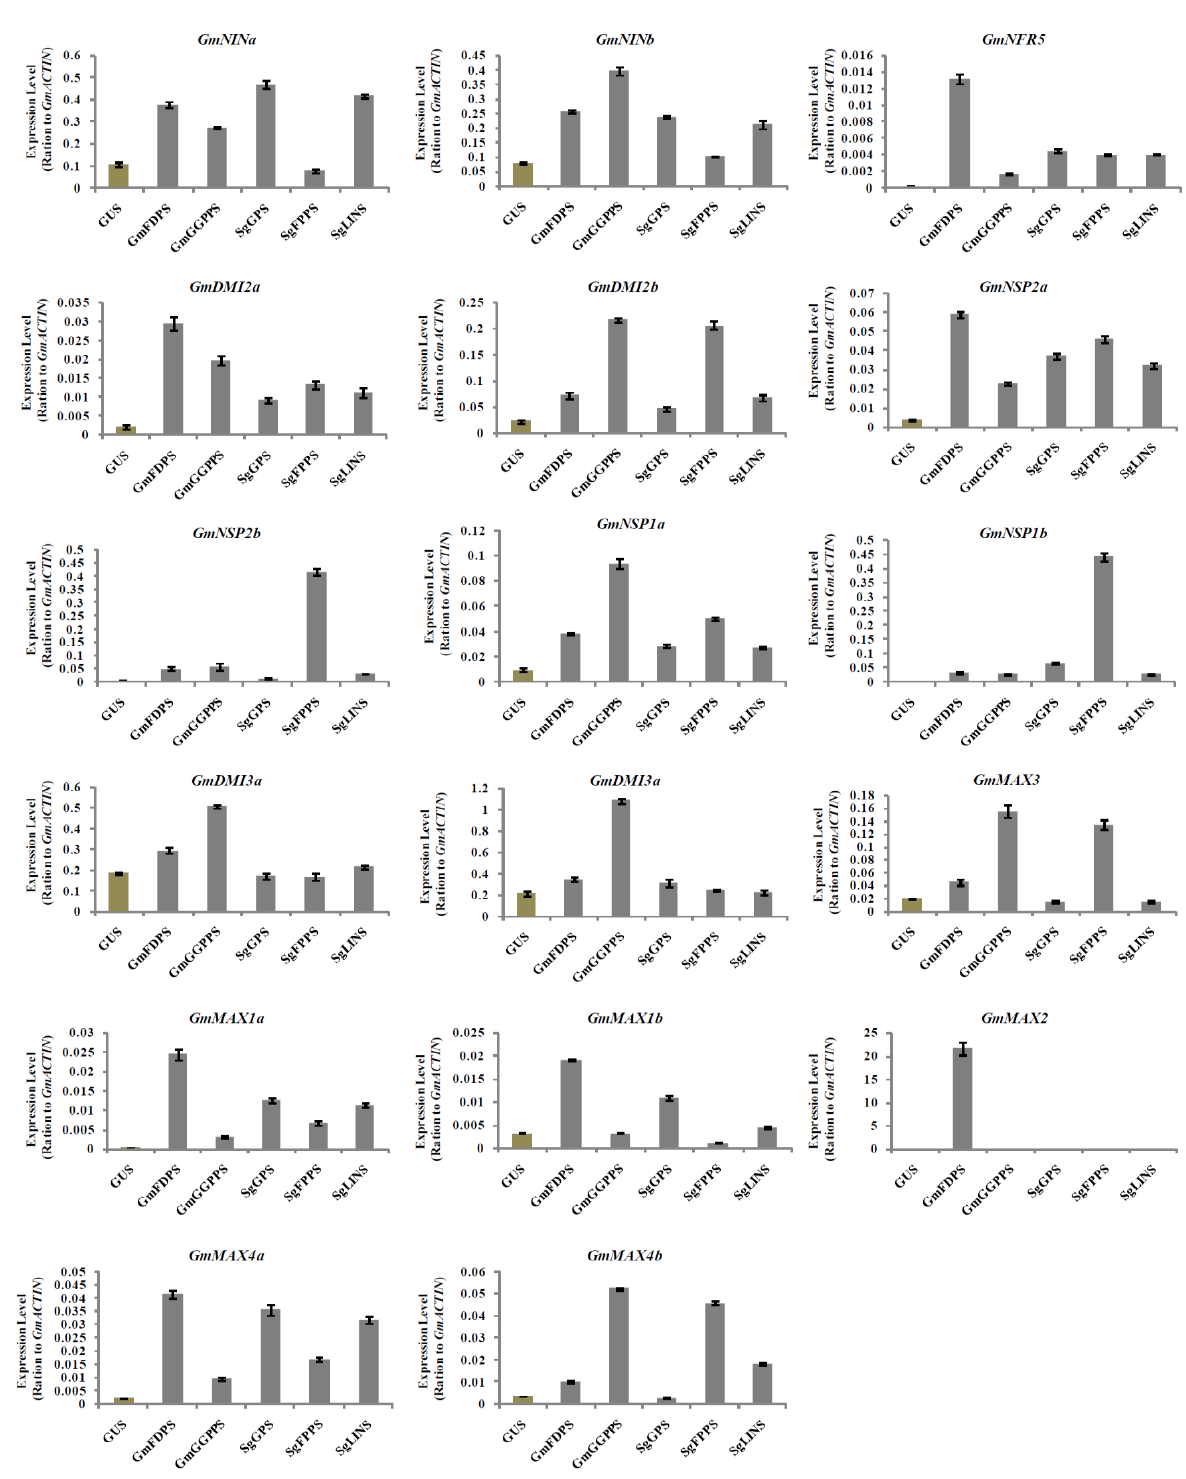
Figure 8. Expression profiles of SL biosynthesis and nodulation genes in soybean nodules after 20 days of rhizobia inoculation. Gene expression was analyzed using quantitative real-time PCR compared to GUS as a control. The housekeeping GmB-ACTIN gene was used as an internal reference gene for expression normalization. The error bars indicate the SD of three qRT-PCR biological replicates.